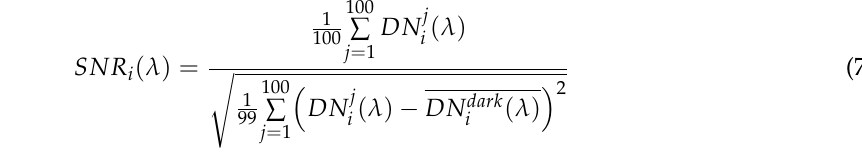
Figure 14. Spectral radiance curves of integrating sphere and solar.